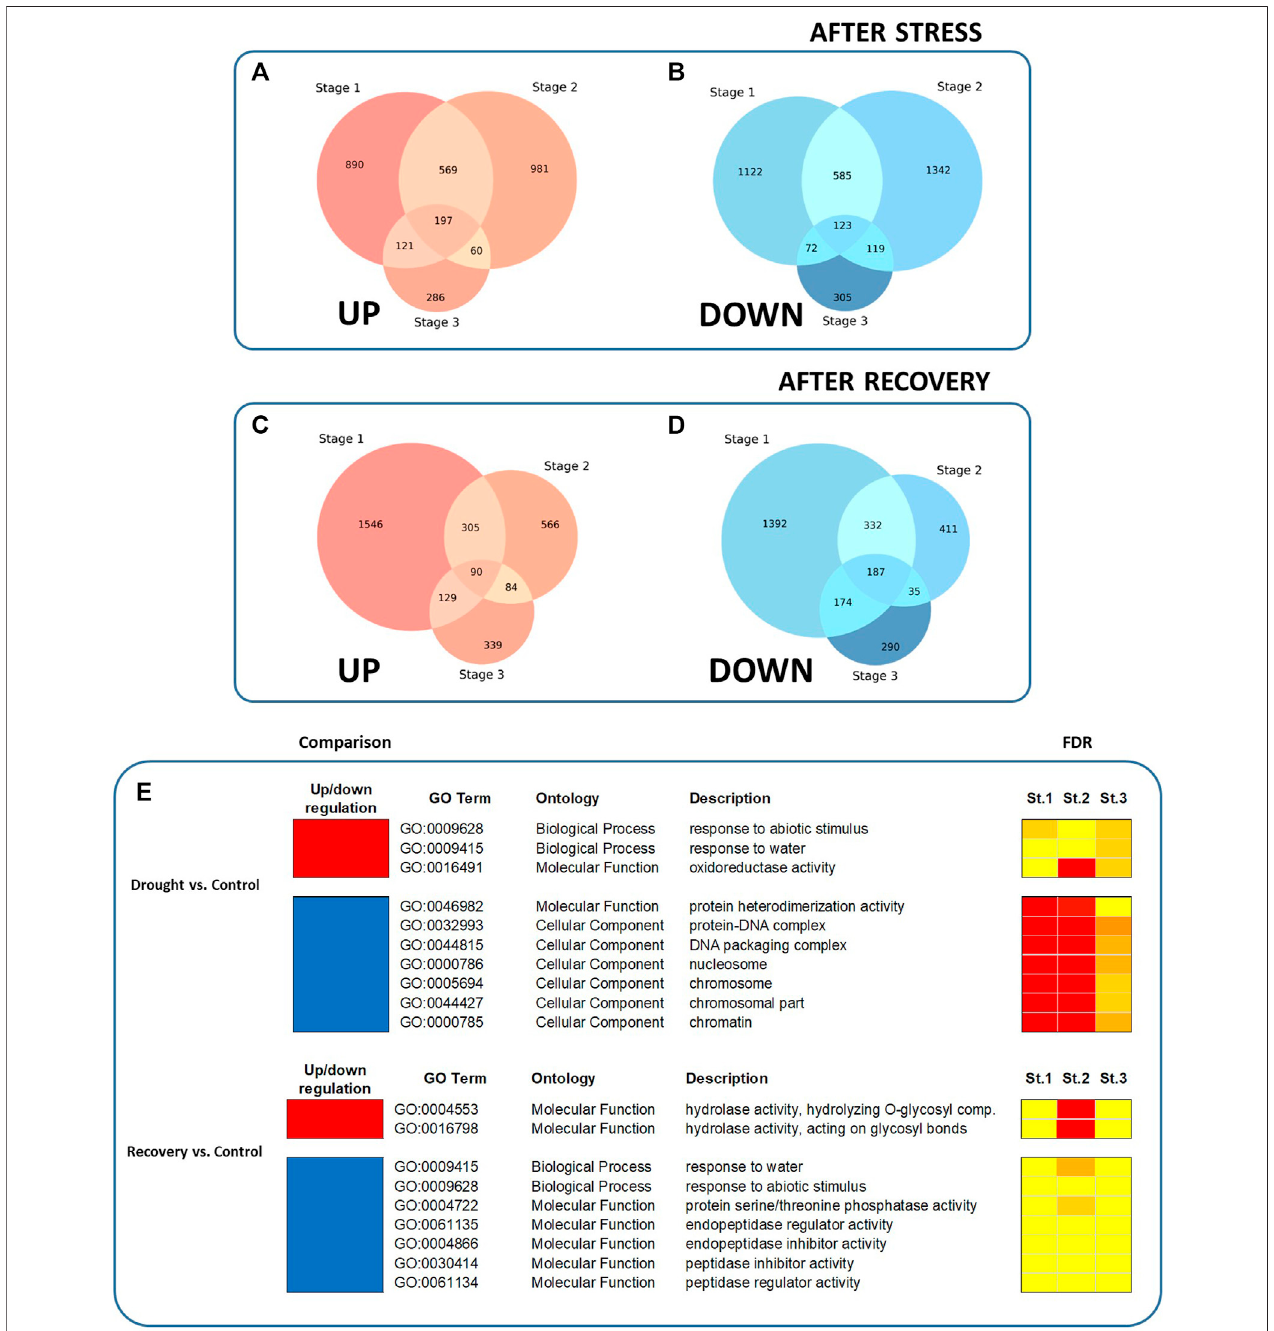
FIGURE 2 | Venn diagram showing intersections of up- or downregulated DEGs, and enriched GO terms, among the DEGs in response to drought and after recovery. (A) Genes upregulated after water stress, compared to control plants. (B) Genes downregulated after water stress. (C) Genes upregulated after recovery. (D) Genes downregulated after recovery. (E) Enriched GO terms are shown for the three stages of plant development (i.e., St.1 (cid:1) fi ve true leaves, St.2 (cid:1) production of third fl ower, and St.3 (cid:1) setting of fi rst fruit). Red color represents upregulated GO terms whereas blue color represents downregulated GO terms. Colors on the FDR columns represent different signi fi cance levels (yellow: FDR < 0.05; orange: FDR < 0.01; red: FDR < 0.001.